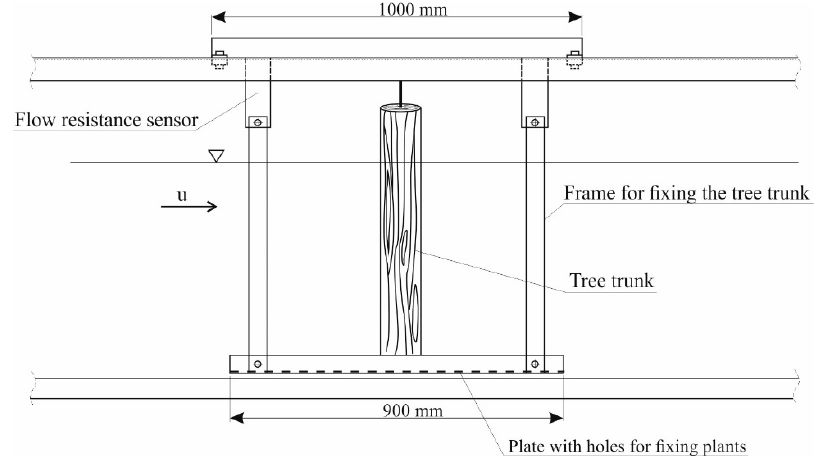
Figure 3. Scheme of the measuring setup and view of the hydraulic trough.